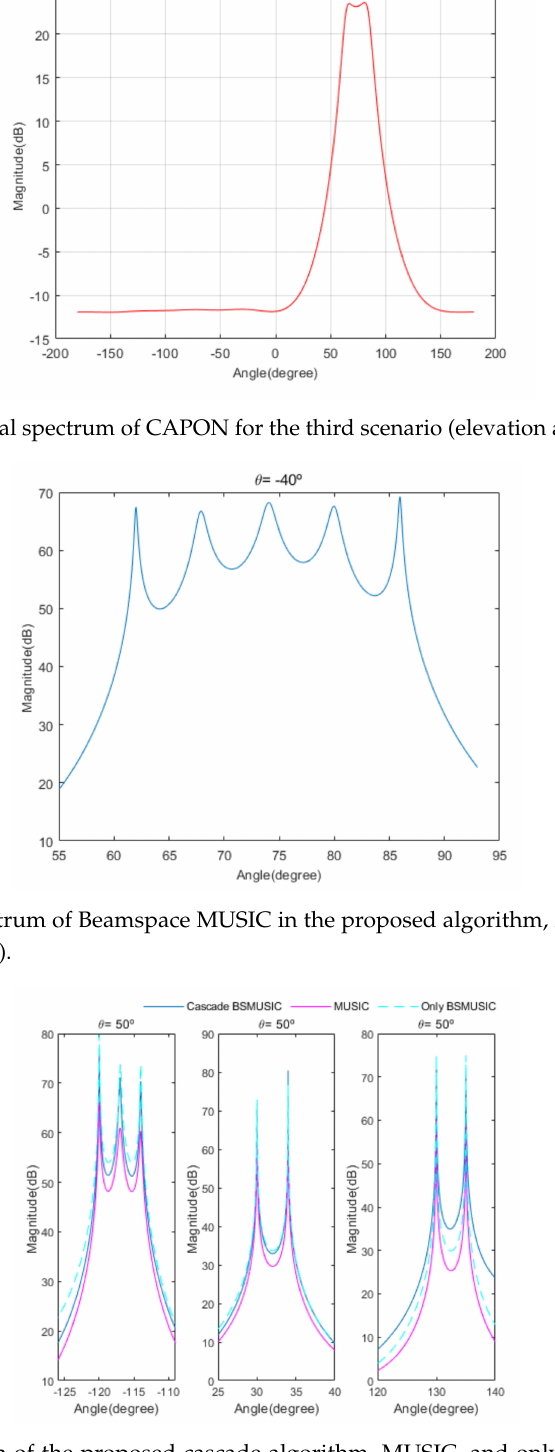
Figure 13. Comparison of the proposed cascade algorithm, MUSIC, and only Beamspace MUSIC, for the first